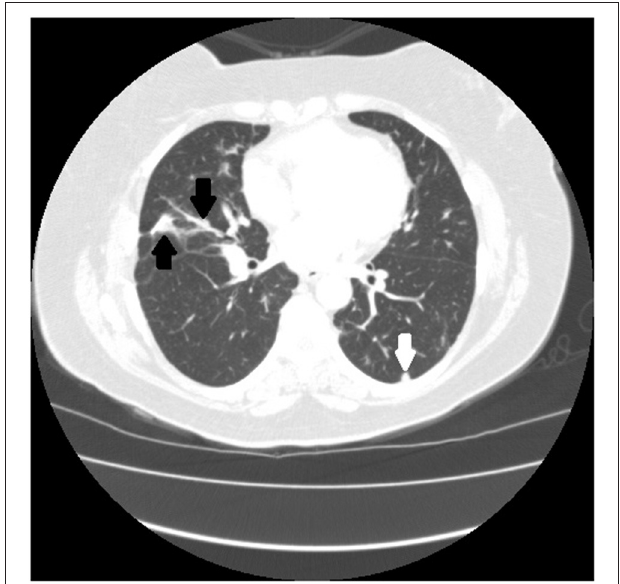
FIGURE 5 | Chest CT scan of granulomatous-lymphocytic interstitial lung disease from common variable immunodeficiency. This condition may have identical radiographic and histologic findings of sarcoidosis. Nodules are demonstrated along the bronchovascular bundle (black arrows) and a subpleural nodule (white arrow) that are commonly observed with sarcoidosis (see Figures 1 , 2 ).